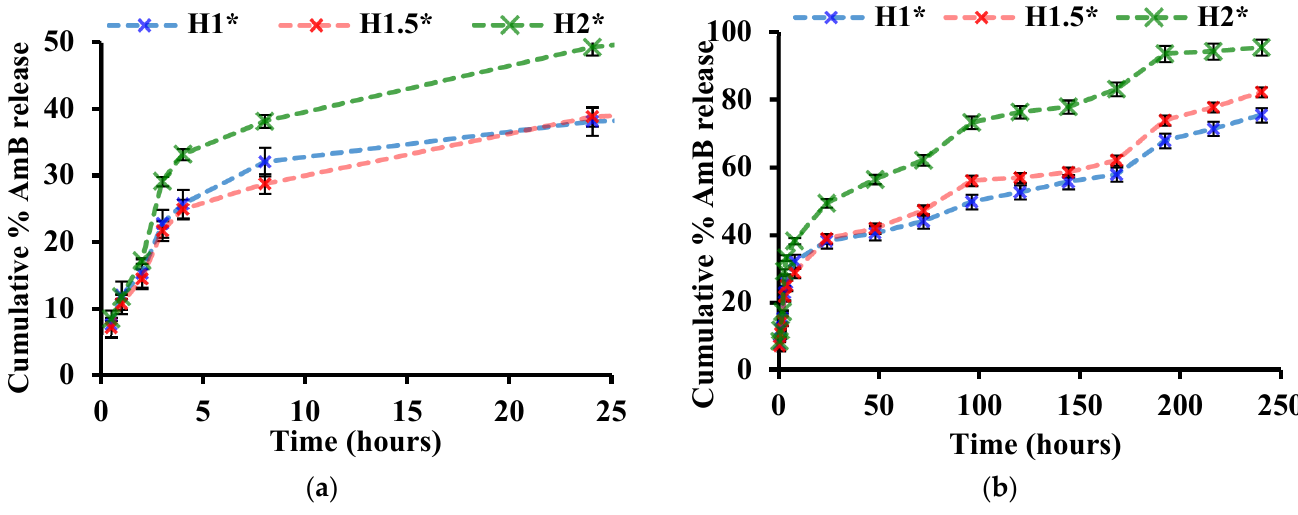
Figure 6. The experimental release kinetic curves for the formulations for the first 8 h ( a ) and for the 240 h during the experiment ( b ).